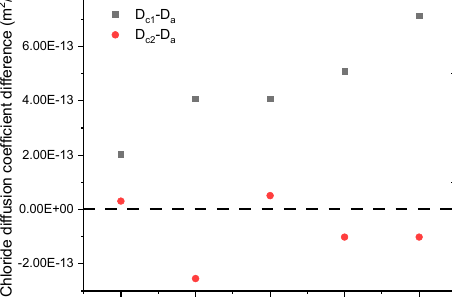
Figure 9. Chloride diffusion coefficient difference with NTB 355 and Truc methods (D c1 denotes the chloride diffusion coefficient determined by Truc method, linear regression was started from 24 h; D c2 denotes the chloride diffusion coefficient determined by Truc method, linear regression was started from 60 h; D a denotes the chloride diffusion coefficient determined by NTB 335 method).